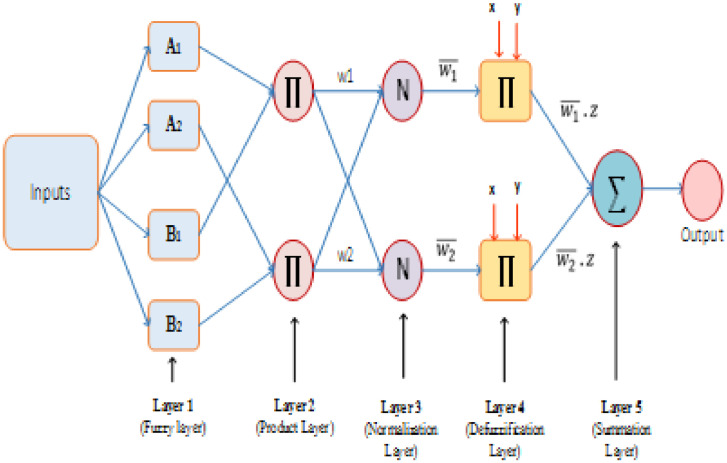
ANFIS architecture.